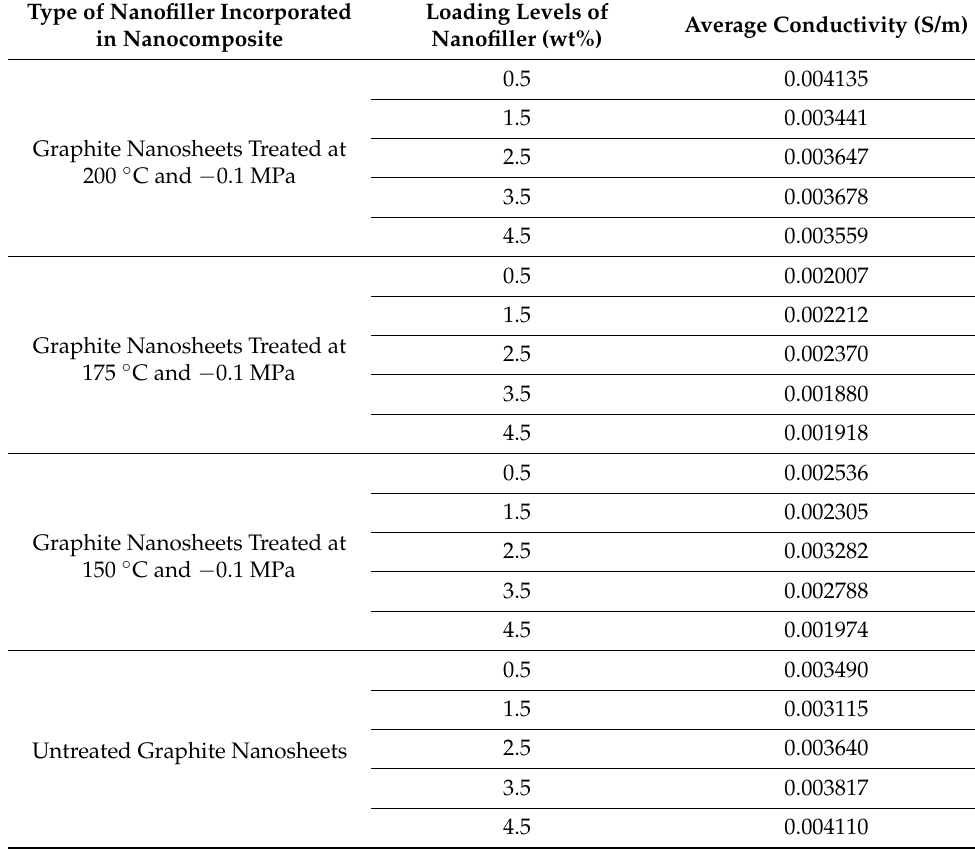
Table 1. Average Conductivity of All the Nylon 610/Graphite Nanosheets